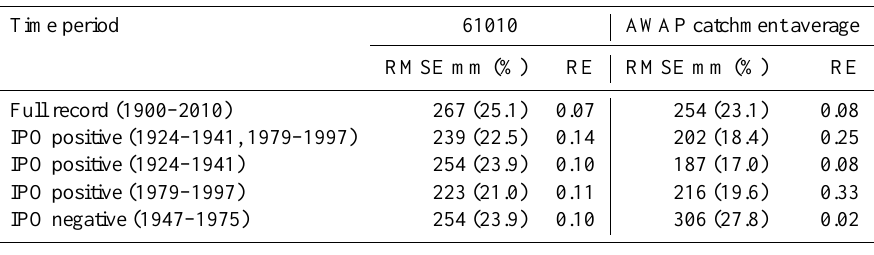
Table 2. Root mean square error in mmyear − 1 (%) and reduction in error between the rainfall reconstruction and 12-month average (October–September) rainfall recorded at gauge 61010 and the AWAP WR catchment average for the 1900–2010 period and IPO phases.